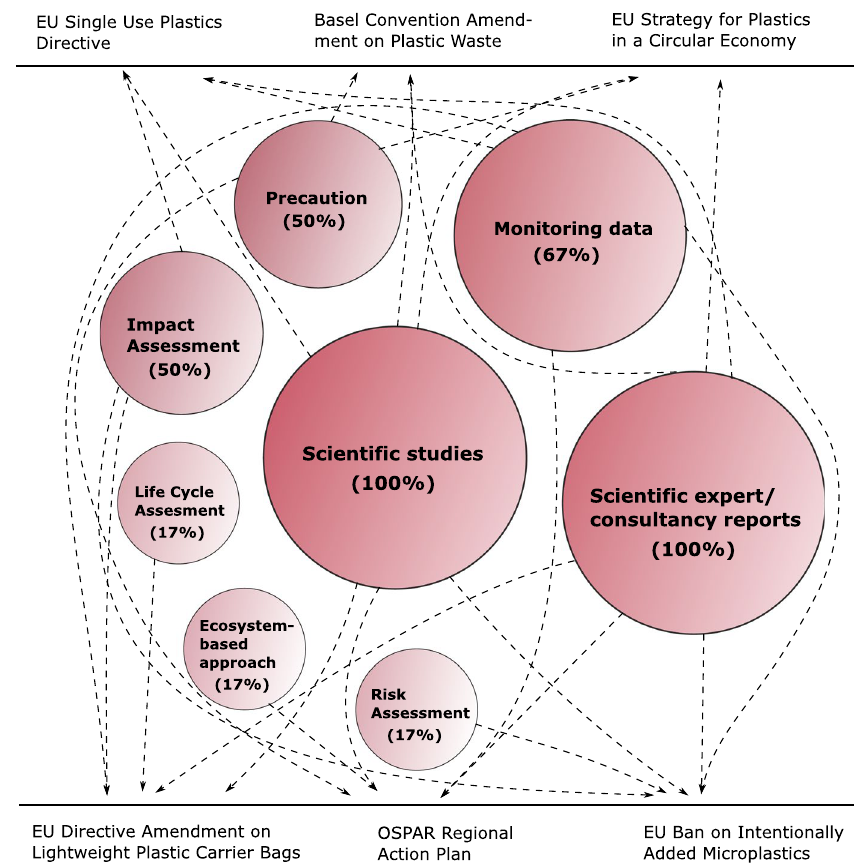
Fig. 2 Type of scientific evidence, tools and principles in the preparatory work underpinning six key policy initiatives targeting plastic pollution. Arrows indicate which types have been applied in the preparatory work of each of the policy initiative(s). The size of the circles and percentages reflect the quantity of the investigated policy initiatives that apply each type of scientific evidence/tools/principles (bigger circle application). The categories can overlap, e.g., many of the reports conducted by scientific experts or consultancy organisations are based on scientific studies and/or monitoring data. Abbreviations: EU: European